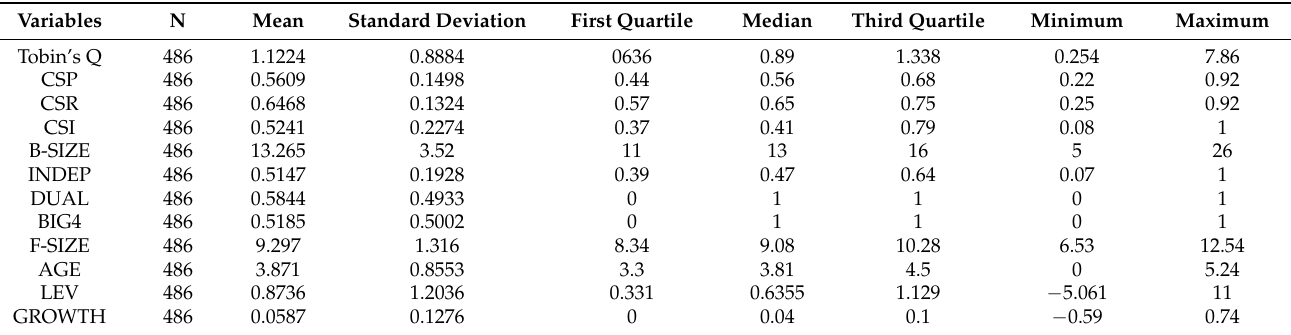
Table 1. Descriptive statistics of key variables.